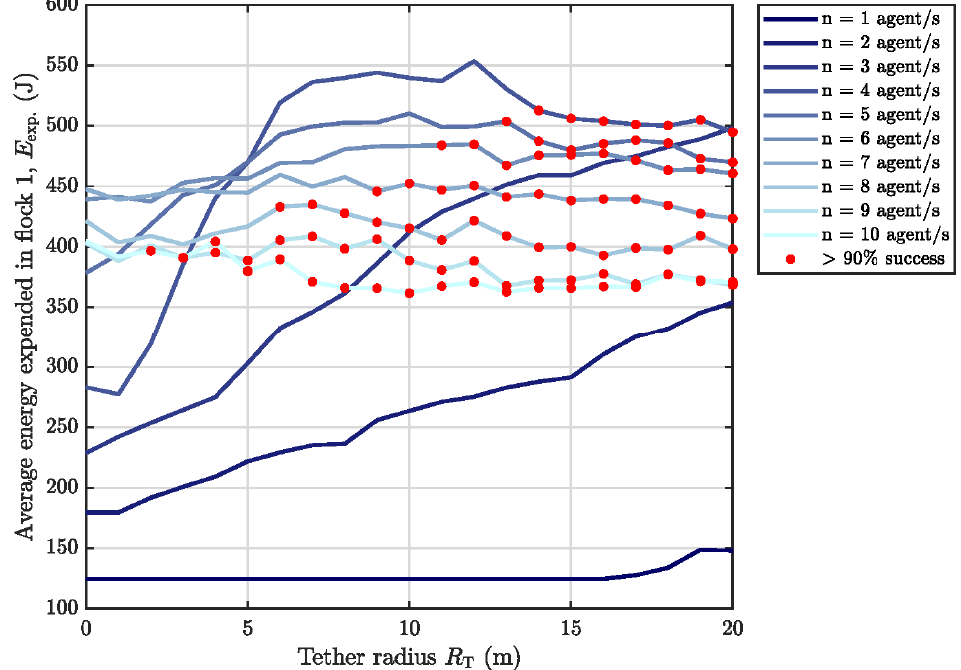
Figure 12. Double target flock scenarios–energy performance (darker lines indicate fewer agent numbers while red markers indicate data points whose average success rate is above the given threshold across the 300 independent simulation runs). Maximum agent speed 𝑣 max = 12 m/s.